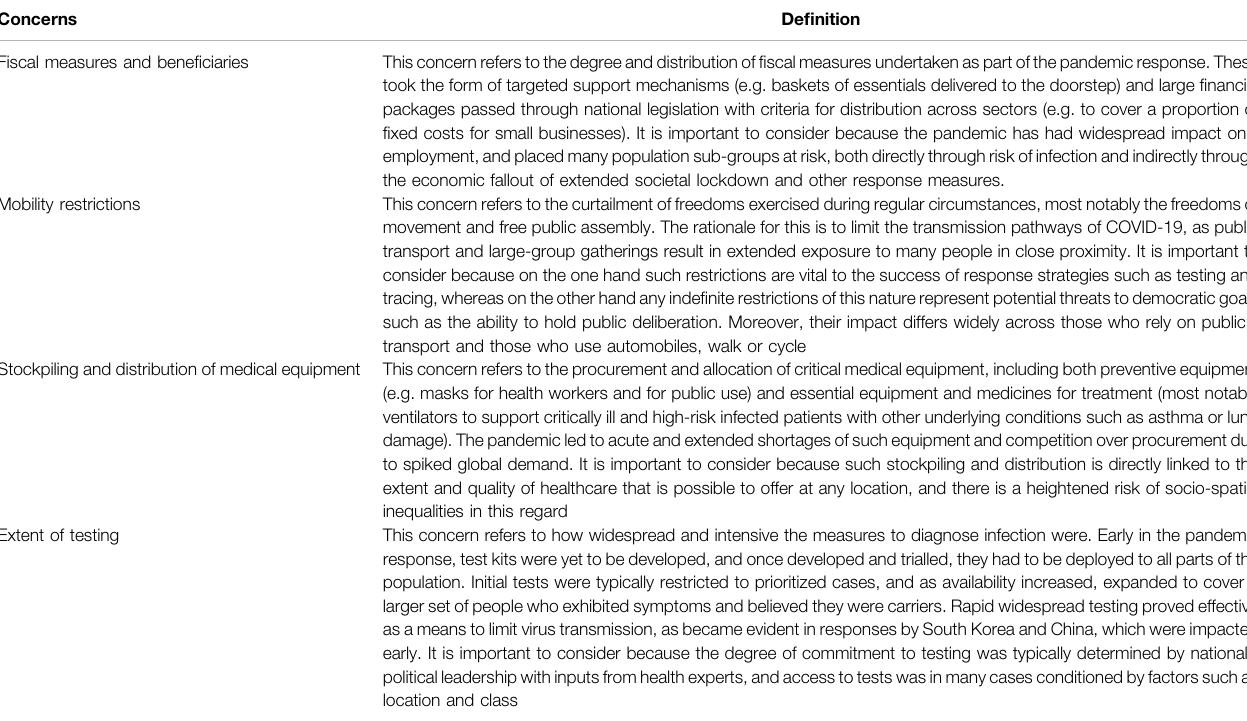
TABLE 1 | De fi ning concerns that feature in immediate and short-term pandemic responses.